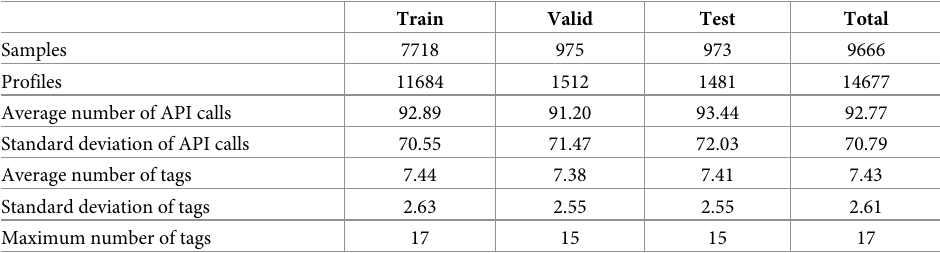
Table 4. Dataset statics.